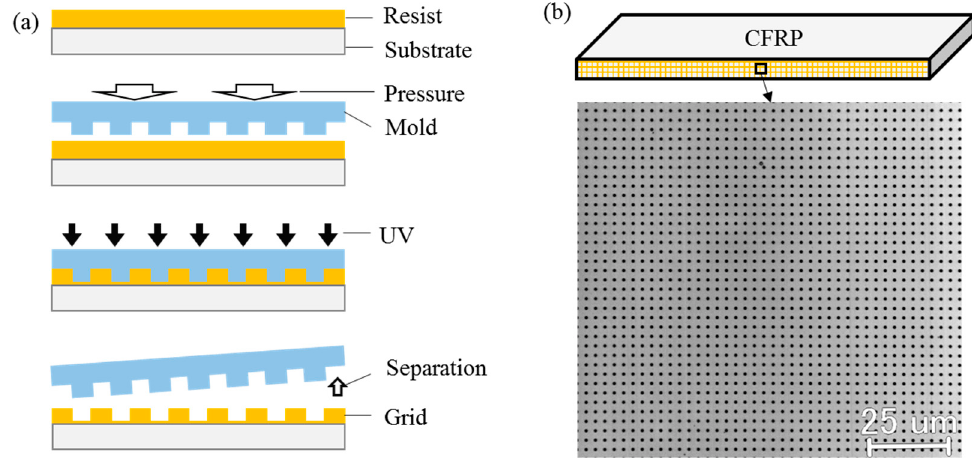
Figure 4. Microscale grid fabrication: ( a ) Process of ultraviolet (UV) nanoimprint lithography; ( b ) grid image fabricated on CFRP specimen.